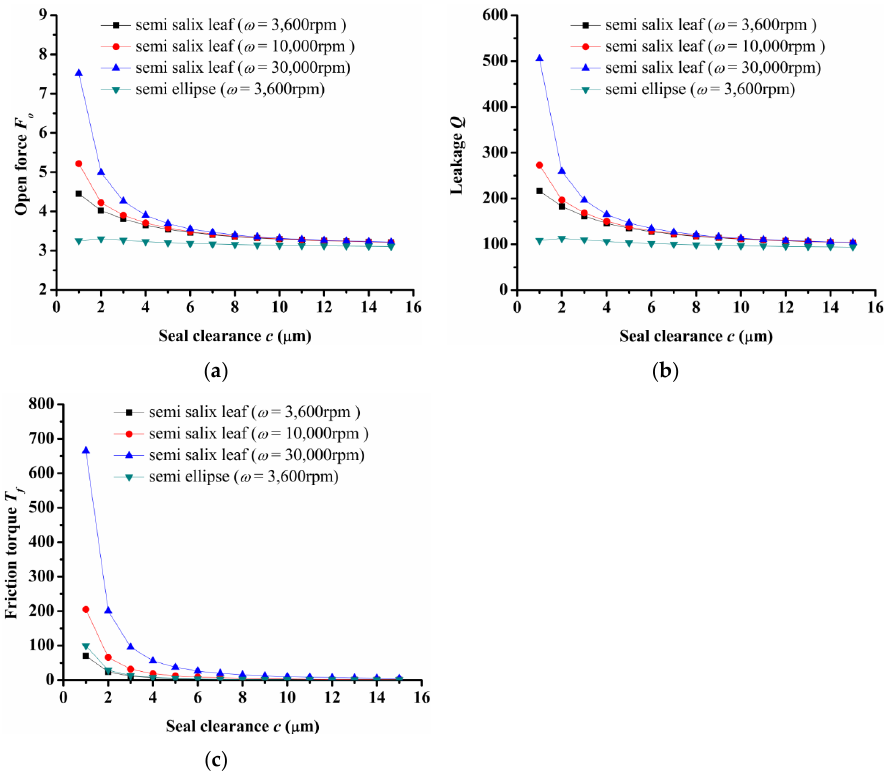
Figure 6. Influence of seal clearance on seal performance: ( a ) opening force, ( b ) leakage, ( c ) friction torque.